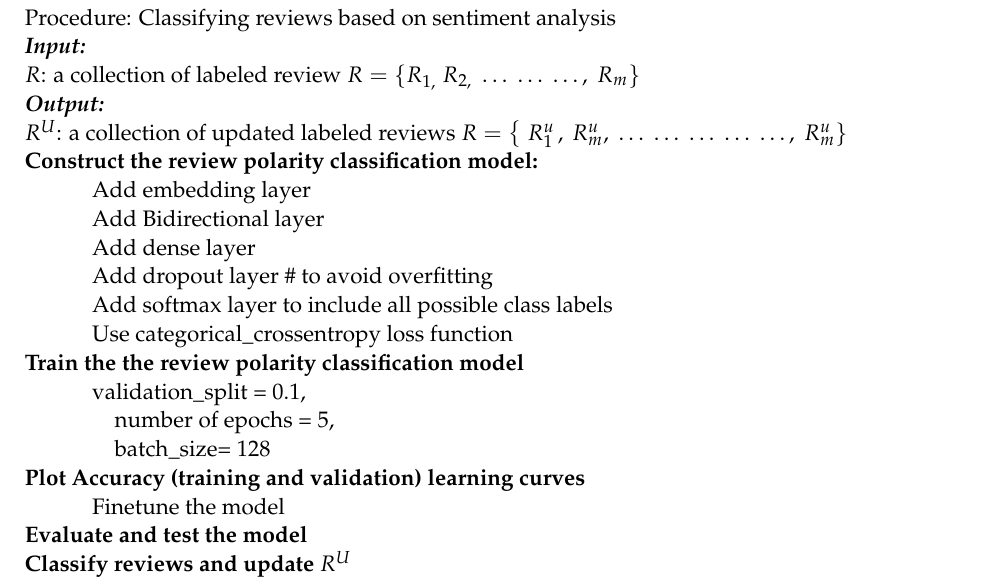
Algorithm 1: The proposed polarity classification based on sentiment